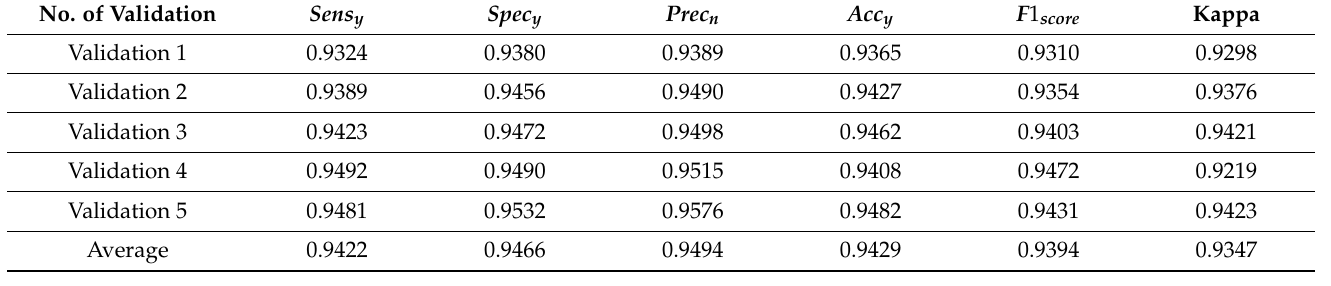
Table 1 and Figures 5–7 investigate the classifier outcome analysis of the GSO-IDCNN